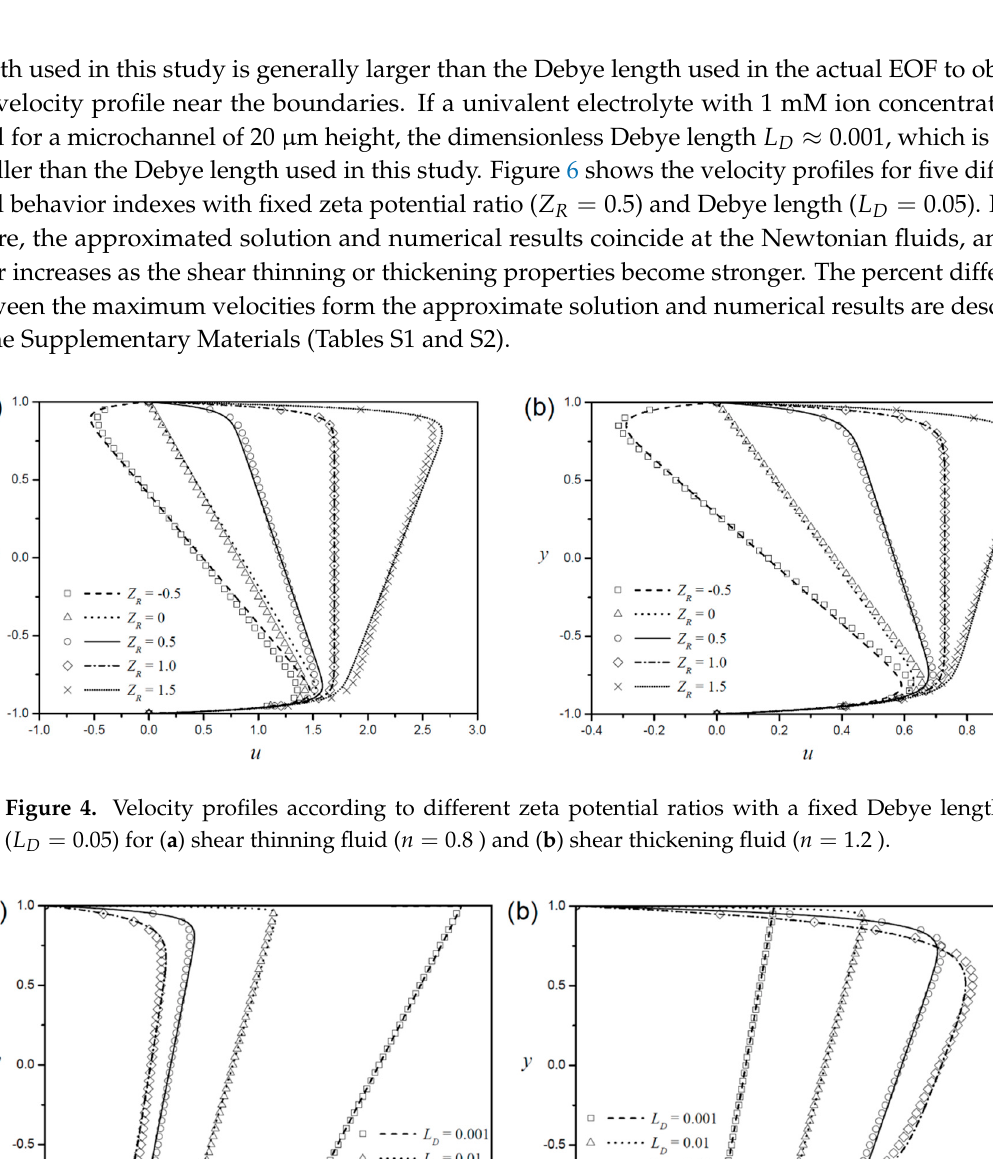
Figure 5. Velocity profiles according to the Debye length with a fixed zeta potential ratios ( Z R = 1.5) for ( a ) shear thinning fluid ( n = 0.8 ) and ( b ) shear thickening fluid ( n = 1.2